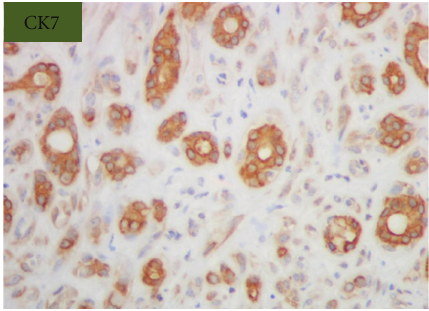
Figure 8: Epithelial stains, CK7 (original magnification × 400).